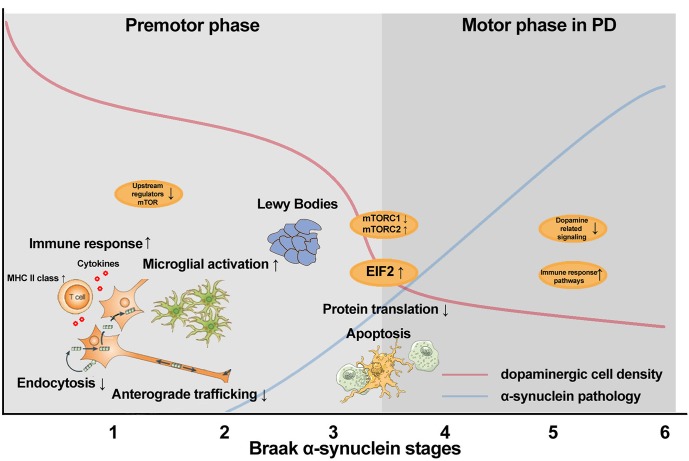
Schematic overview of molecular processes altered during disease progression in the SN of PD, identified using transcriptome analysis.In Braak alpha-synuclein 1 and 2, minimal cell loss is observed along with decreased endocytosis and anterograde trafficking, and increased immune response and microglial activation. In addition, we observed down regulation of mRNA levels of the upstream regulators in mTOR pathway. In Braak alpha-synuclein 3 and 4, a steep decline in cell loss and increase in alpha-synuclein pathology is observed together disturbed regulation of protein production and apoptosis of the nigral dopaminergic cells. In Braak alpha-synuclein 5 and 6 compared to controls, severe cell loss and alpha-synuclein aggregation is observed [41]. At this advanced stage, alterations in pathways related to dopaminergic signaling and immune response are still observed.